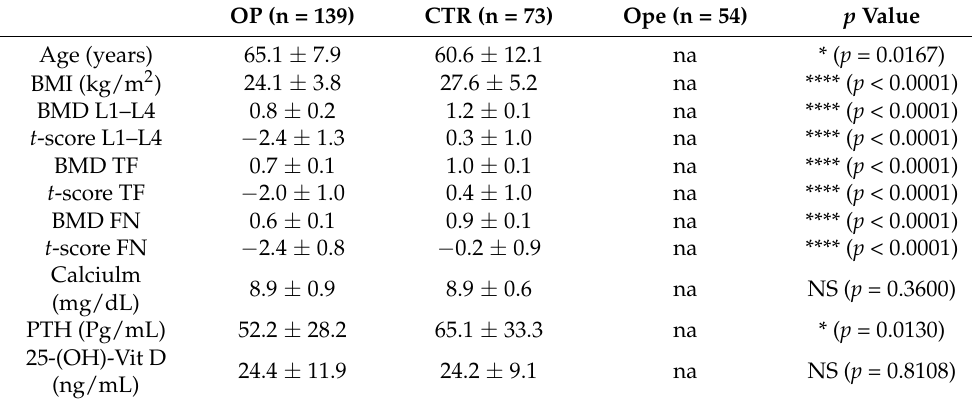
Table 1. Clinical features of OP, CTR and Ope subjects.